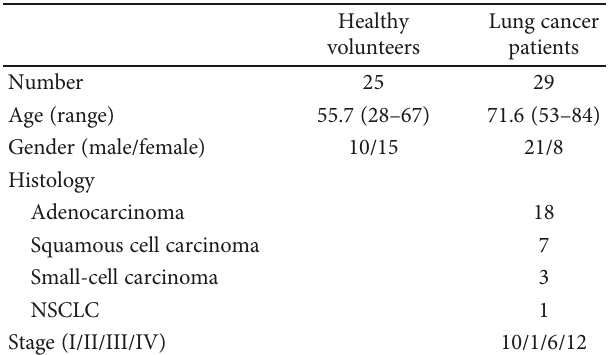
Figure 2: DC count by subtype. Lineage( − ), HLA-DR(+), and CD11c(+) myeloid DC (mDC) and Lineage( − ), HLA-DR(+), and CD123( − ) plasmacytoid DC (pDC) fractions were counted and compared between the stage I+ II and stage III+IV cancer patients. Signi fi cantly fewer mDCs were observed in stage III+ IV cancer patients compared with the controls, and signi fi cantly fewer pDCs were observed in stage I+ II and stage III+IV lung cancer patients compared with the controls.